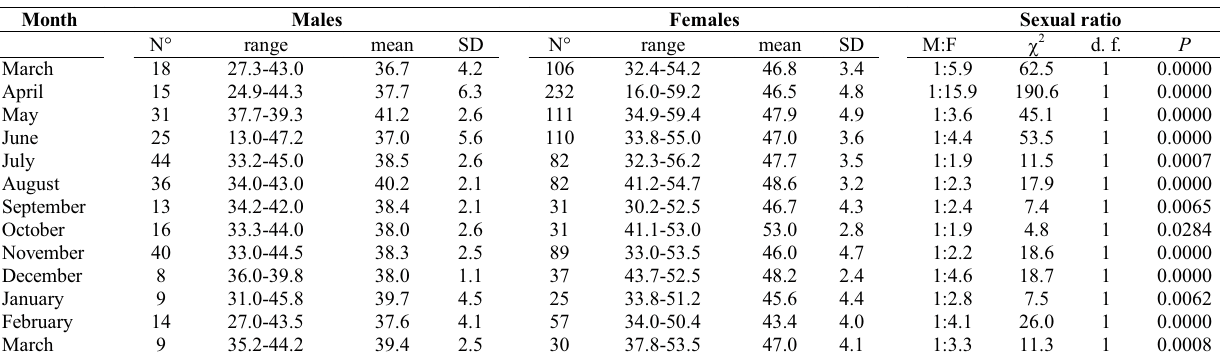
Table 2. Number of males and females of Rioraja agassizi captured by month; total length range (cm), mean total length (mean), standard deviation (SD) and sex ratio males:females (M:F), along with (cid:70) 2 test’s value, degrees of freedom (d. f.) and probability